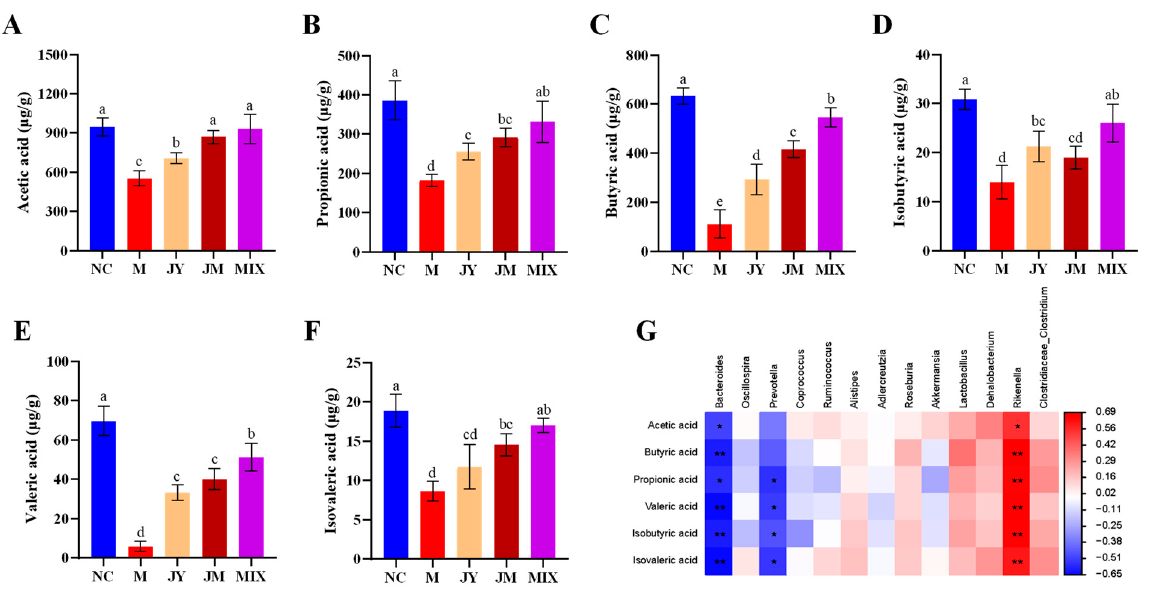
Figure 7. The effect of probiotics on short-chain fatty acids (SCFAs) in mice: ( A ) content of acetic acid; ( B ) content of propionic acid; ( C ) content of butyric acid; ( D ) content of isobutyric acid; ( E ) content of valeric acid; ( F ) content of isovaleric acid; ( G ) correlation between gut microbiota and SCFAs. Different letters (a, b, c, d and e) denote significant differences between different groups of mice ( p < 0.05). * p < 0.05 and ** p < 0.01 represent significant correlation between gut microbiota and SCFAs. NC stands for the normal control group, M for the model group, JY for the L. paracasei JY062 group, JM for the L. gasseri JM1 group, and MIX for the combination